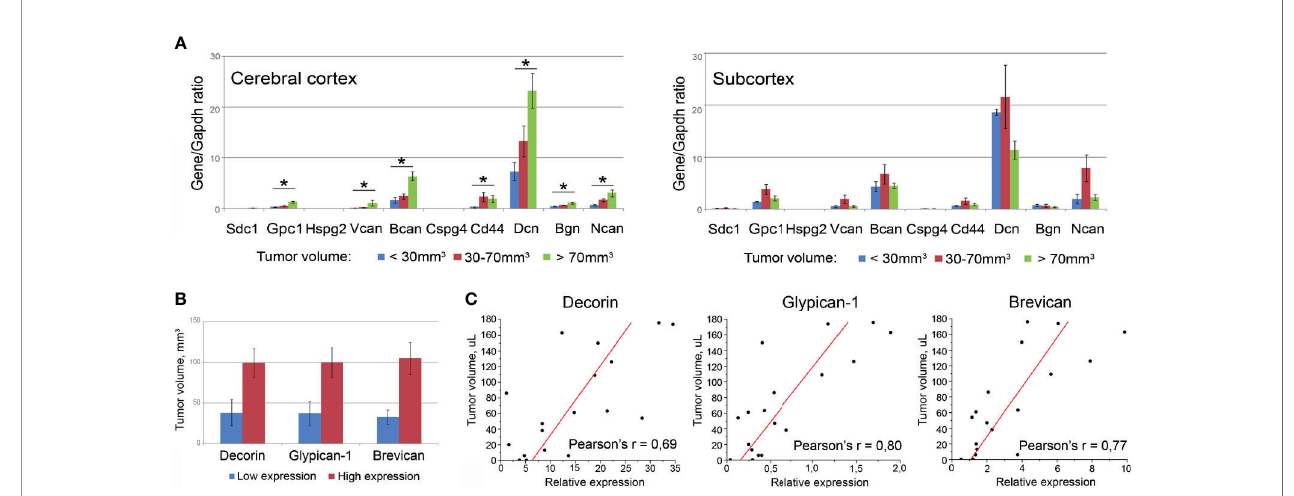
FIGURE 6 | Association of the PGs expression levels in surrounding tumor normal tissue with the total volume of U87 xenografts. (A) PG expression levels in brain tissue of animals grouped according to the xenograft tumors size (small <30 µl; medium 30-70 µl; big >70 µl). Bars represent the mean ± SD from triplicate experiments (OriginPro 8.5). ANOVA + Fisher ’ s LSD test, *p < 0.05. (B) Tumor volumes in animals with relatively high or low expression of selected PGs (decorin, brevican, glypican-1). (C) Pearson ’ s linear correlation of the xenograft volumes with the expression levels of the PGs in surrounding normal brain tissue (OriginPro